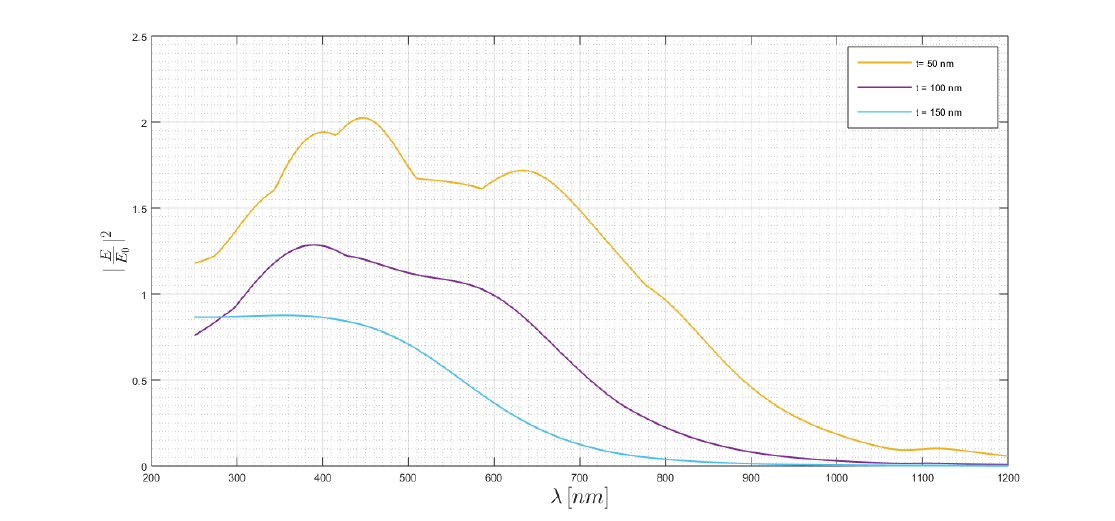
Figure 14. Nanoantenna thickness sweep on the aluminum nanostructure.